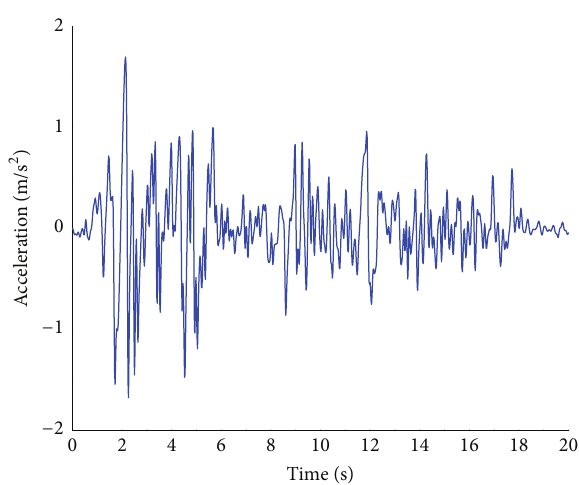
Figure 5: 𝑋 -acceleration time history curve of input seismic